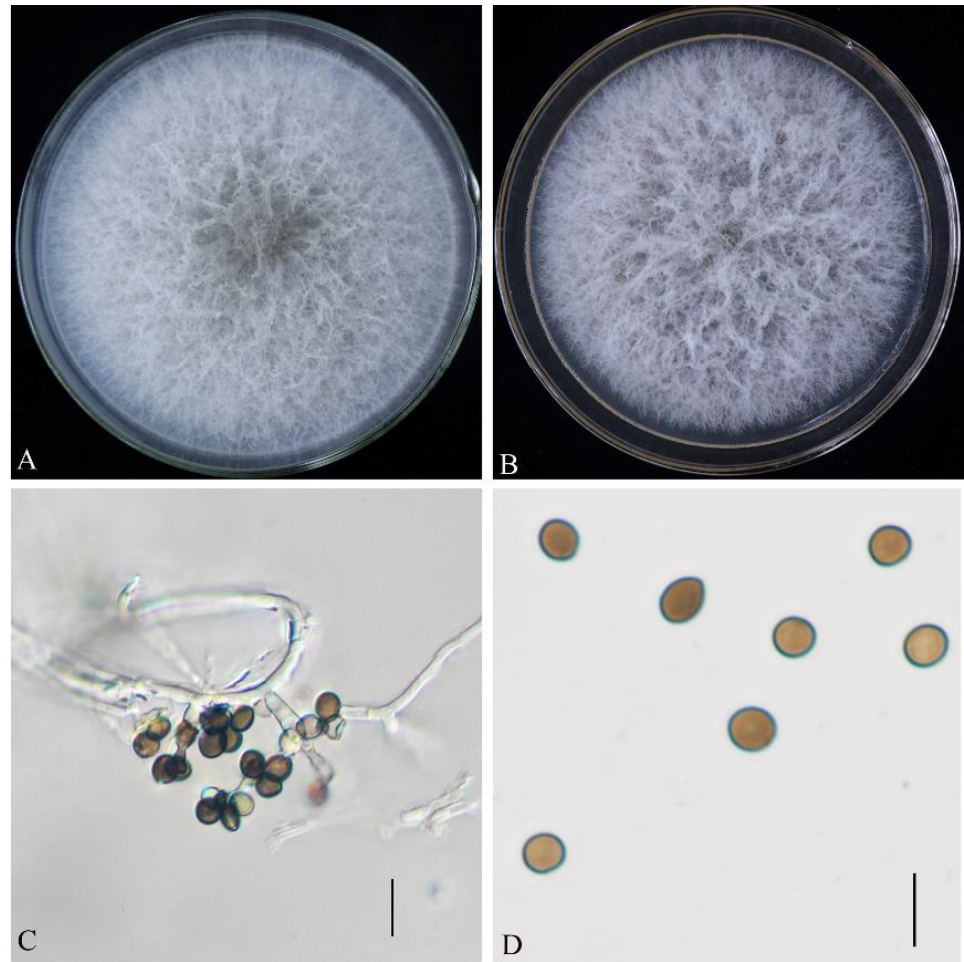
Figure 3. Morphology of the isolate BBB1. ( A ) Colony morphology of 5-day-old on PDA; ( B ) Colony morphology of 5-day-old on MEA; ( C ) Conidiogenous cells; ( D ) Conidia; Scale bars: 10 μm.